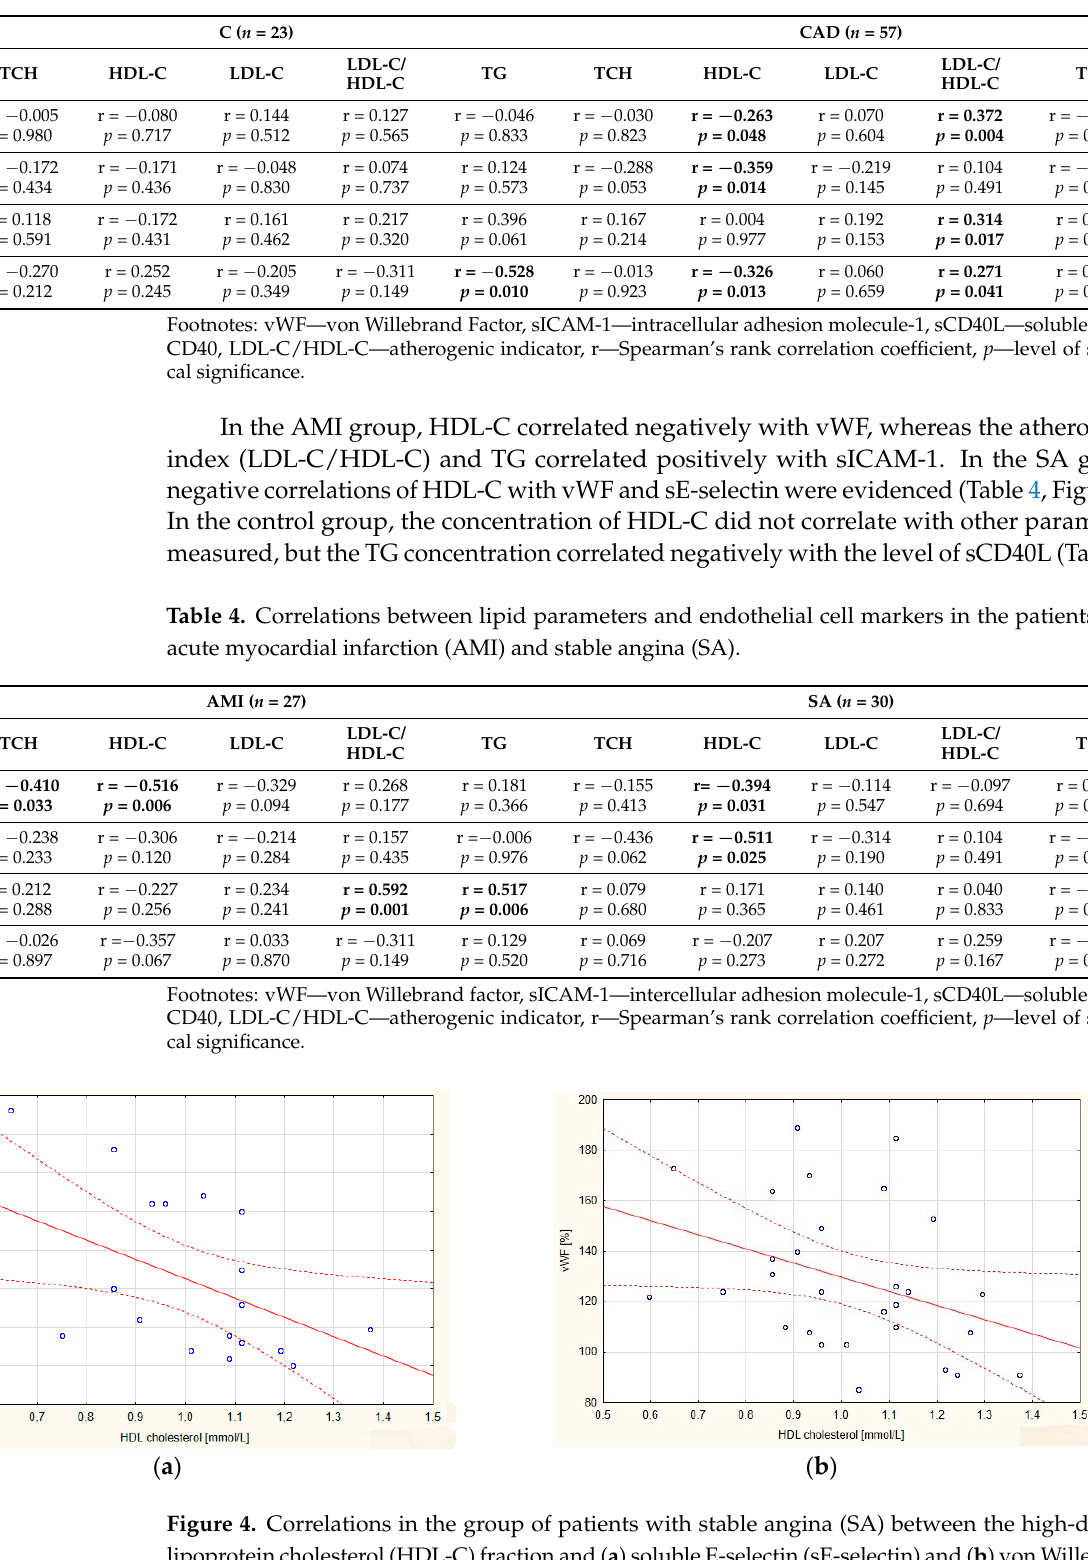
Table 3. Correlations between lipid parameters and endothelial cell markers in the coronary artery disease (CAD) patients and control (C) subjects without cardiac symptoms.